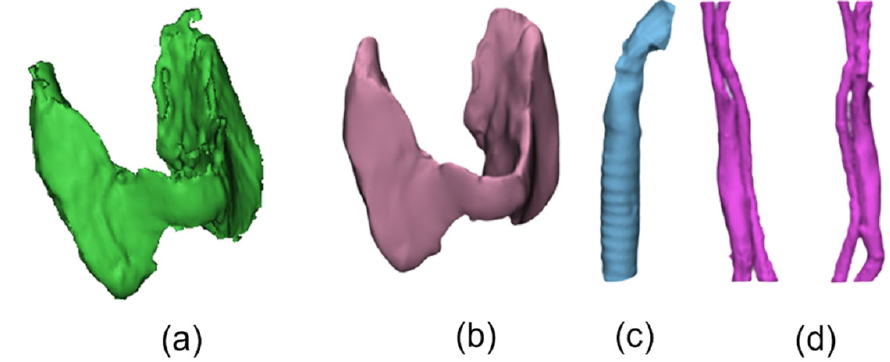
Figure 16. Representation of segmented inner anatomical structures: ( a ) thyroid (before smoothen- ing/treatment) and ( b ) thyroid (after smoothening), ( c ) trachea, and ( d ) veins and arteries. With all the inner anatomy structures segmented, the complete 3D model is obtained, for later fusion with the 3D thermal outer shell. The result showing the 3D reconstruction and visualization of all the structures combined, including the inner structures and the external geometry of the neck, is shown in Figure 17.